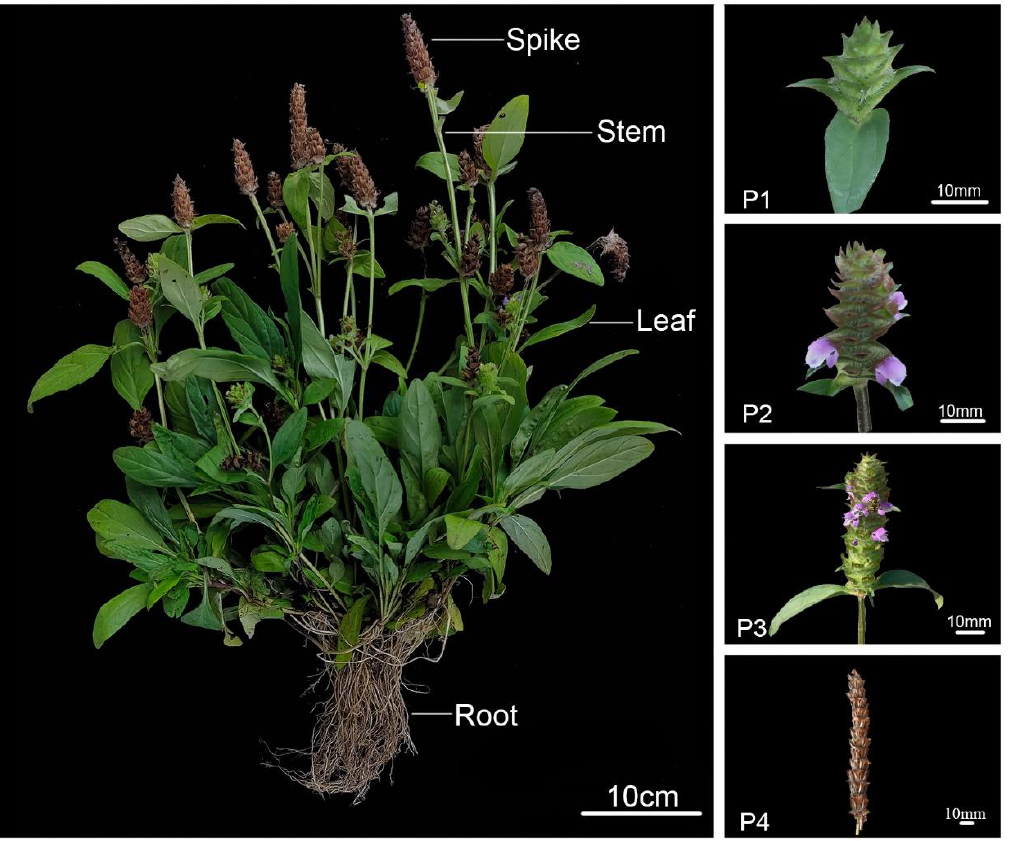
Figure 1. Intact plants and four distinct developmental stages of Spica Prunellae. P1: bolting stage; P2: early flowering stage; P3: complete flowering stage; P4: mature stage.